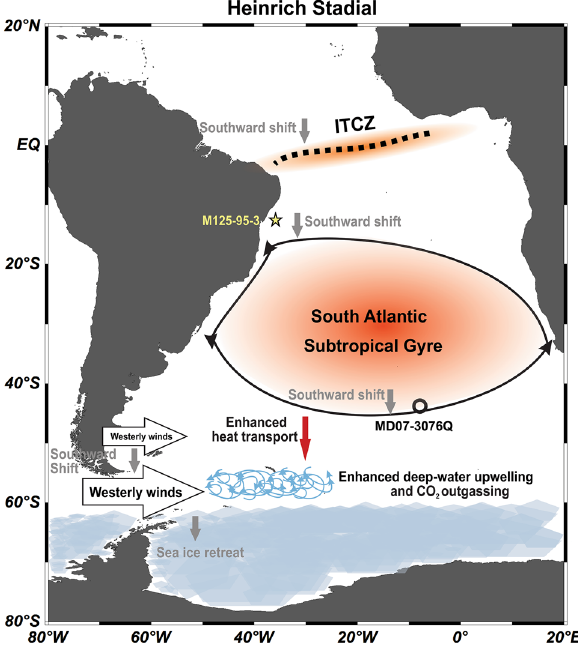
Figure 4. Schematic representation of the mechanism by which a southward displacement of the South Atlantic Subtropical Gyre during a Heinrich Stadial transfer more heat to the Southern Ocean, ultimately fostering CO 2 release to the atmosphere. This figure was produced using the Ocean Data View software 29 (ODV—version 5.2.1., https:// odv. awi. de, 2020) and the CorelDRAW Graphics Suite software (CorelDRAW—version X6, https:// www. corel draw.